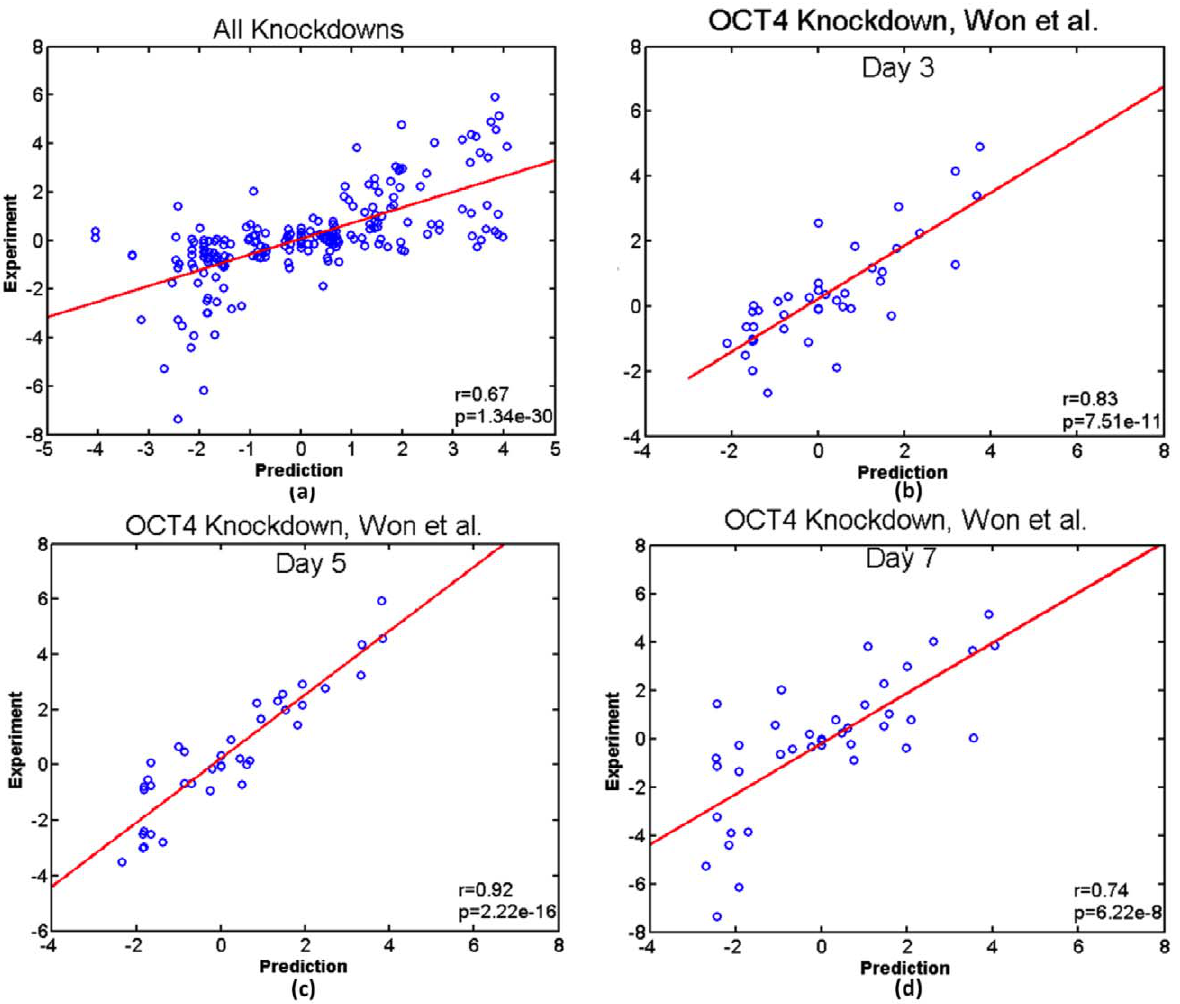
Figure 2. Pearson correlation coefficient (r) and p-value (p) between predicted and experimental gene expression changes (in log2). (A) A scatter plot of predicted and experimental gene expression changes of all OCT4(Won et al., submitted and [54]) and NANOG knockdown [55] experiments; (B), (C) and (D) Scatter plots of day 3, 5 and 7 after knocking down OCT4 using an episomal vector(Won et al., submitted). Reprogramming efficiency. The predicted state of reprogrammed cells should achieve an expression signature similar to hESCs (see